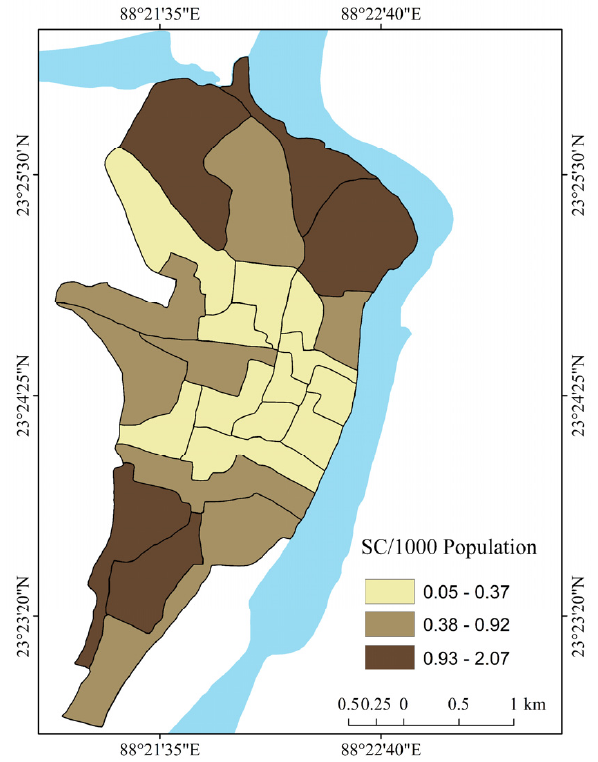
Figure 56. Ward-wise distribution of SC/1000 population in Nabadwip Municipality Figure 56. Ward ‐ wise distribution of SC/1000 population in Nabadwip Municipality (2011).